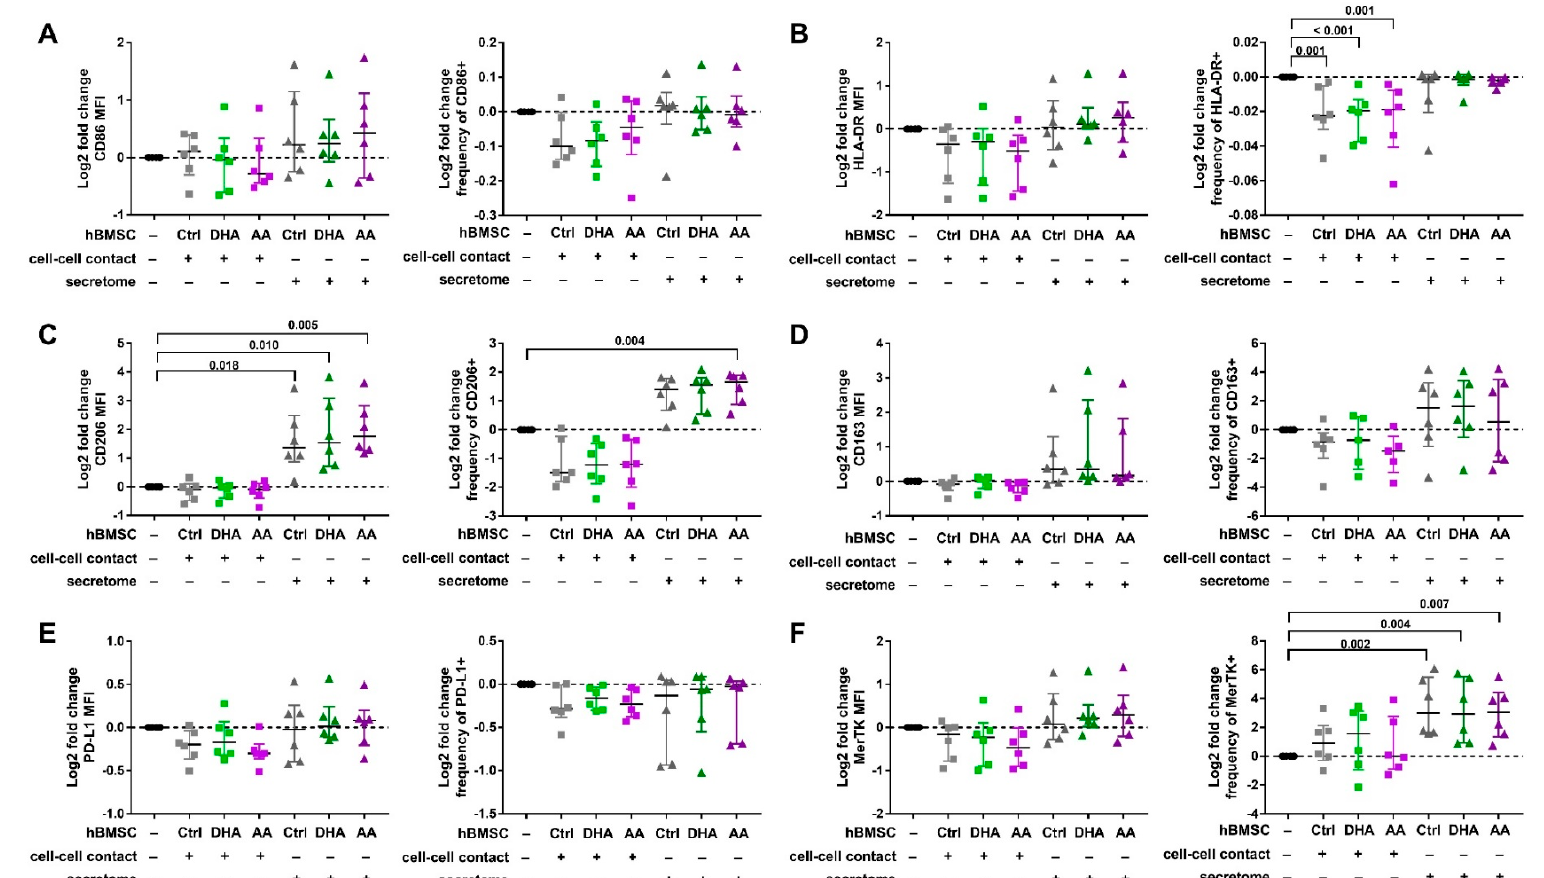
Figure 3. The effect of hBMSC cell-cell contact and secretome on the cell surface the phenotype of Mreg-activated macrophages. The median fluorescence intensities (MFI, on the left in each panel) and frequencies of positive cells (on the right in each panel) were determined with flow cytometry investigating the expression of ( A ) CD86, ( B ) HLA-DR, ( C ) CD206, ( D ) CD163, ( E ) PD-L1 and ( F ) MerTK. The effect of hBMSCs is visualized with log2 fold changes calculated against macrophages cultured without hBMSCs (represented by the zero line) for each individual donor. The differences among groups were determined with Kruskal-Wallis test and post hoc using Dunn’s test. The results are expressed as log2 fold changes as medians with interquartile ranges; n = 6 biological replicates. Ctrl, control; DHA, docosahexaenoic acid; AA, arachidonic acid.